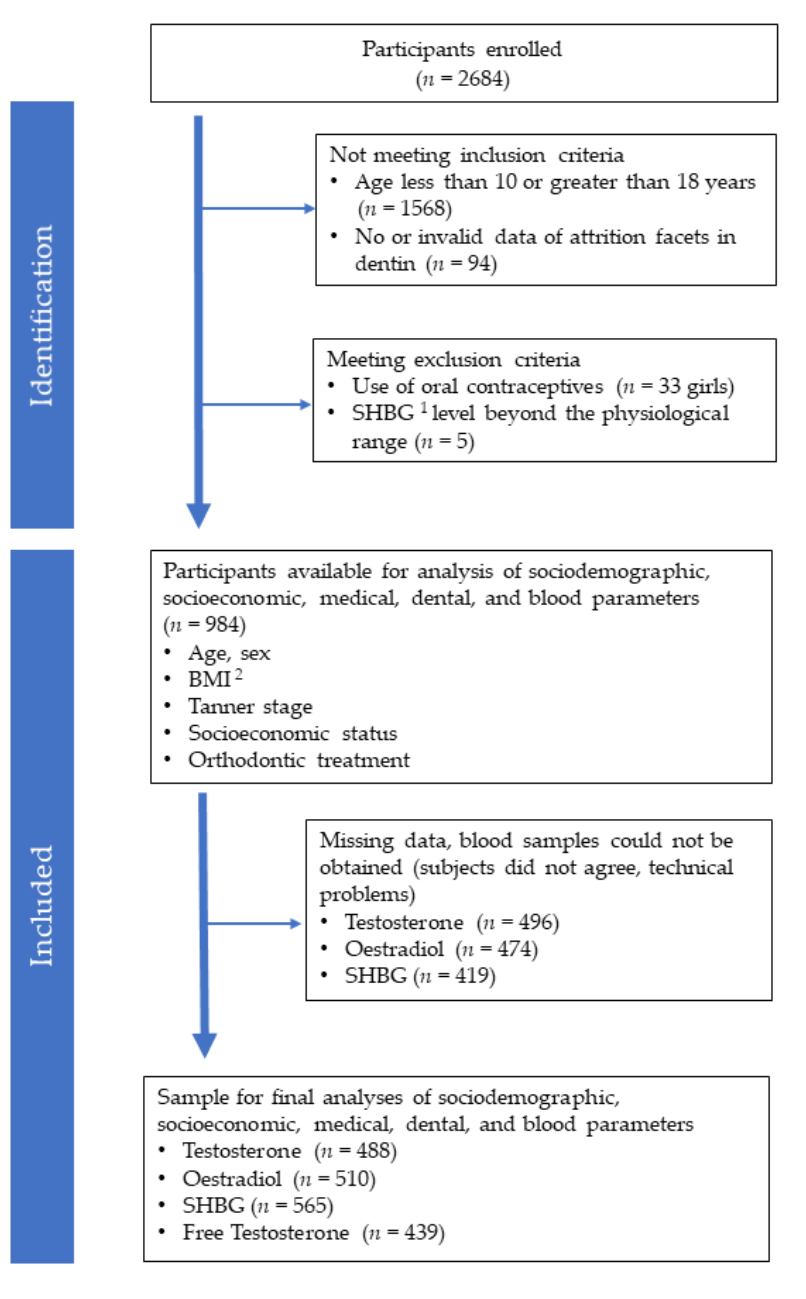
Figure 1. CONSORT flow diagram of study design and